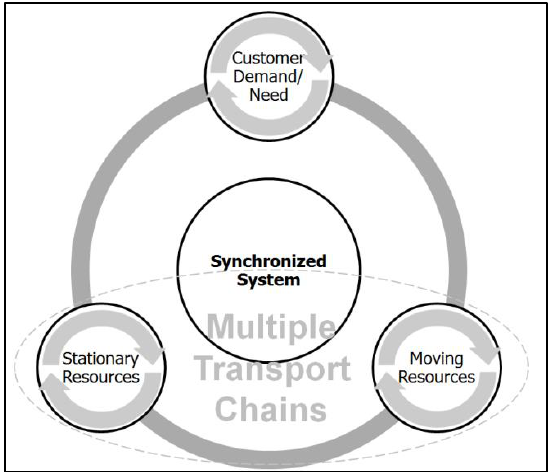
Figure 3. Aspects that must be synchronized in a Synchromodal Freight Transport System The integration of transport chains in a synchromodal transport system includes synchronizing both “Stationary Resources” —like transport infrastructure (e.g., roads, rails, and